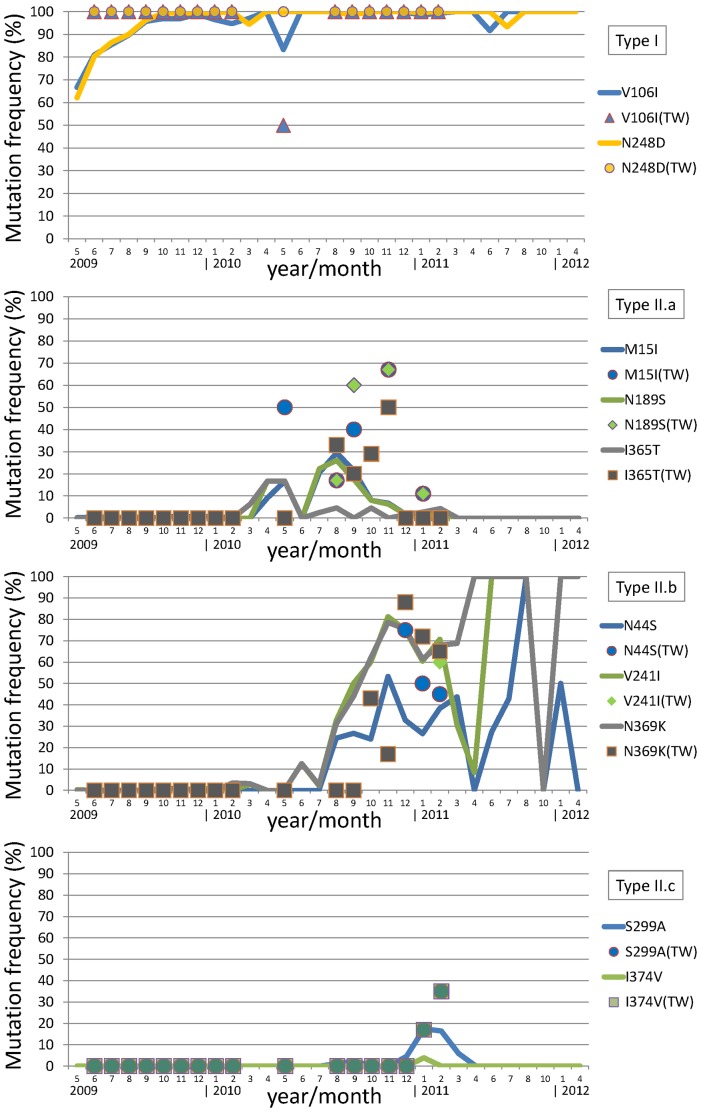
NA mutation dynamics of Taiwanese H1N1pdm viruses versus publicly available H1N1pdm viruses.Horizontal axis represents the year/month the sampling took place, and the vertical axis represents the frequency (in percentage) that one particular mutation occurred in the month. Taiwanese data range from June 2009 to February 2011, and are graphed by various markers (circles, squares, triangles, and diamonds). A total of 6,017 H1N1pdm NA sequences are collected from NCBI which cover a 3-year span from April 2009 to April 2012, and are graphed in thick lines. Mutations are grouped according to the transitioning types described in Table 2, and are displayed from top to bottom as type I, II.a, II.b and II.c.